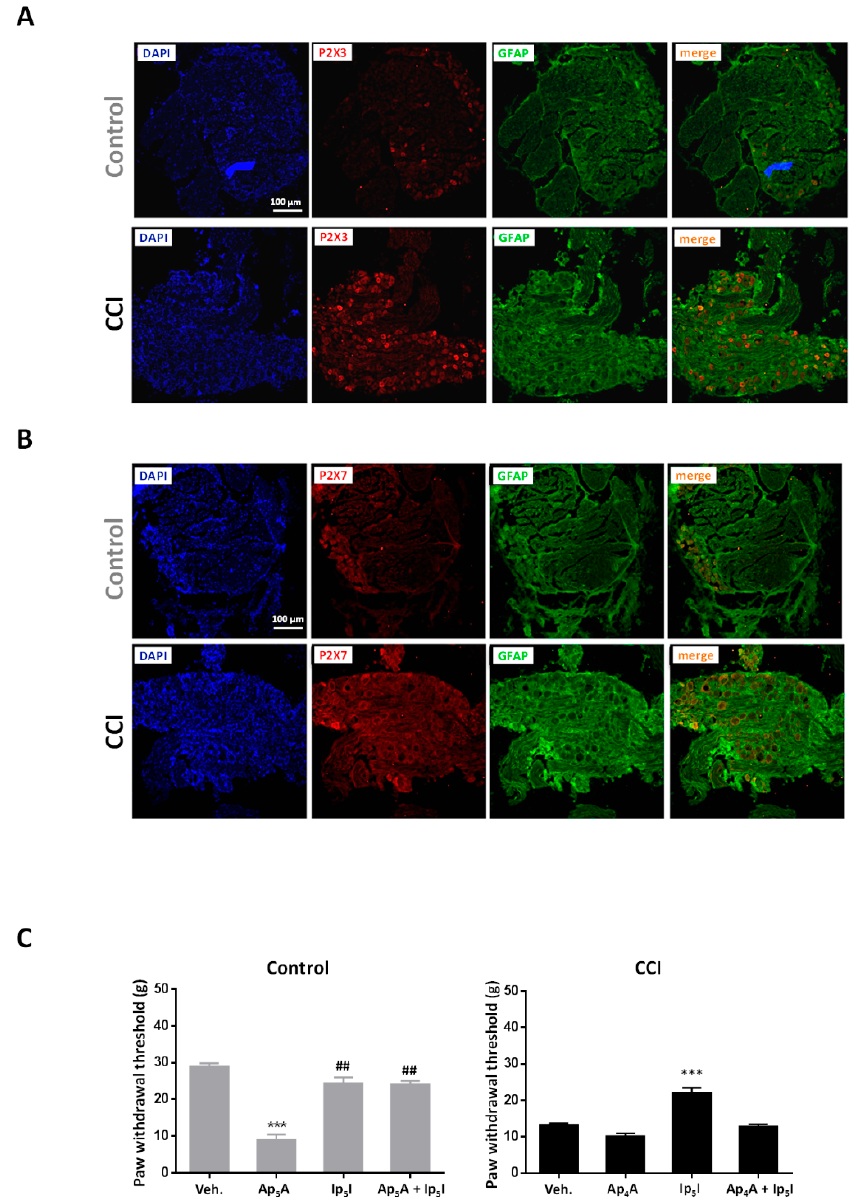
Figure 2. CCI animals show increased P2X3 and P2X7 receptor immunoreactivity in DRG and mechanical allodynia involving P2X3 receptors. ( A ) Fluorescence confocal images of DRG from control (upper panels) and CCI animals (lower panels) stained for P2X3 receptors and glial fibrillary acidic protein (GFAP). ( B ) Fluorescence confocal images of DRG from control (upper panels) and CCI animals (lower panels) stained for P2X7 receptors and GFAP. Cell nuclei in A and B were visualized following incubation with 4 (cid:48) 6-diamidino-2-phenylindole (DAPI). Images are representative of those obtained in DRG from 3 Control and 3 CCI animals. ( C ) Effect of intraplantar (i.pl.) administration of diadenosine polyphosphates on paw withdrawal threshold to mechanical stimulation. Left ; Effect of i.pl. administration of Ap 5 A (2 µ g; n = 6 experiments, 3 rats), Ip 5 I (2 µ g; n = 8 experiments, 4 rats), and co-administration of Ap 5 A and Ip 5 I ( n = 6 experiments, 3 rats) in the hindpaw of control animals. Right ; Effect of i.pl. administration of Ap 4 A (2 µ g; n = 3 experiments, 3 rats), Ip 5 I (2 µ g; n = 8 experiments, 4 rats), and co-administration of Ap 4 A and Ip 5 I ( n = 4 experiments, 4 rats) in the ipsilateral hindpaw of CCI animals. Statistical significance was assessed by a Student t test for unpaired data with respect to vehicle (Veh.; ***, p < 0.001), and for paired data with respect to AP 5 A ( ## , p < 0.01).